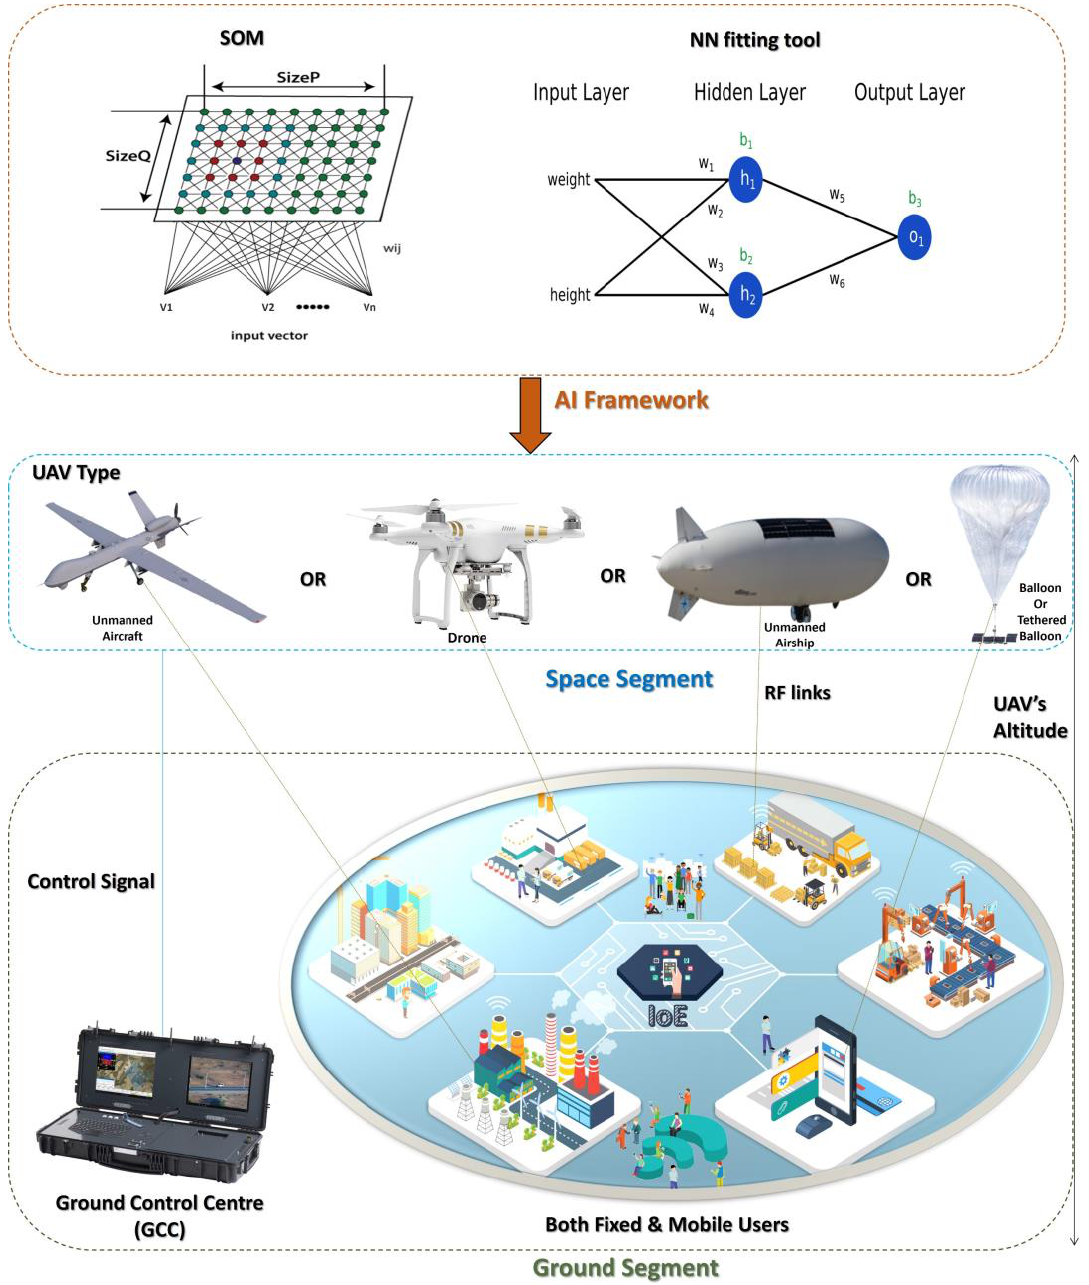
Figure 3. Proposed intelligent heterogenous 5G topology that integrates a UAV-based system with IoE and